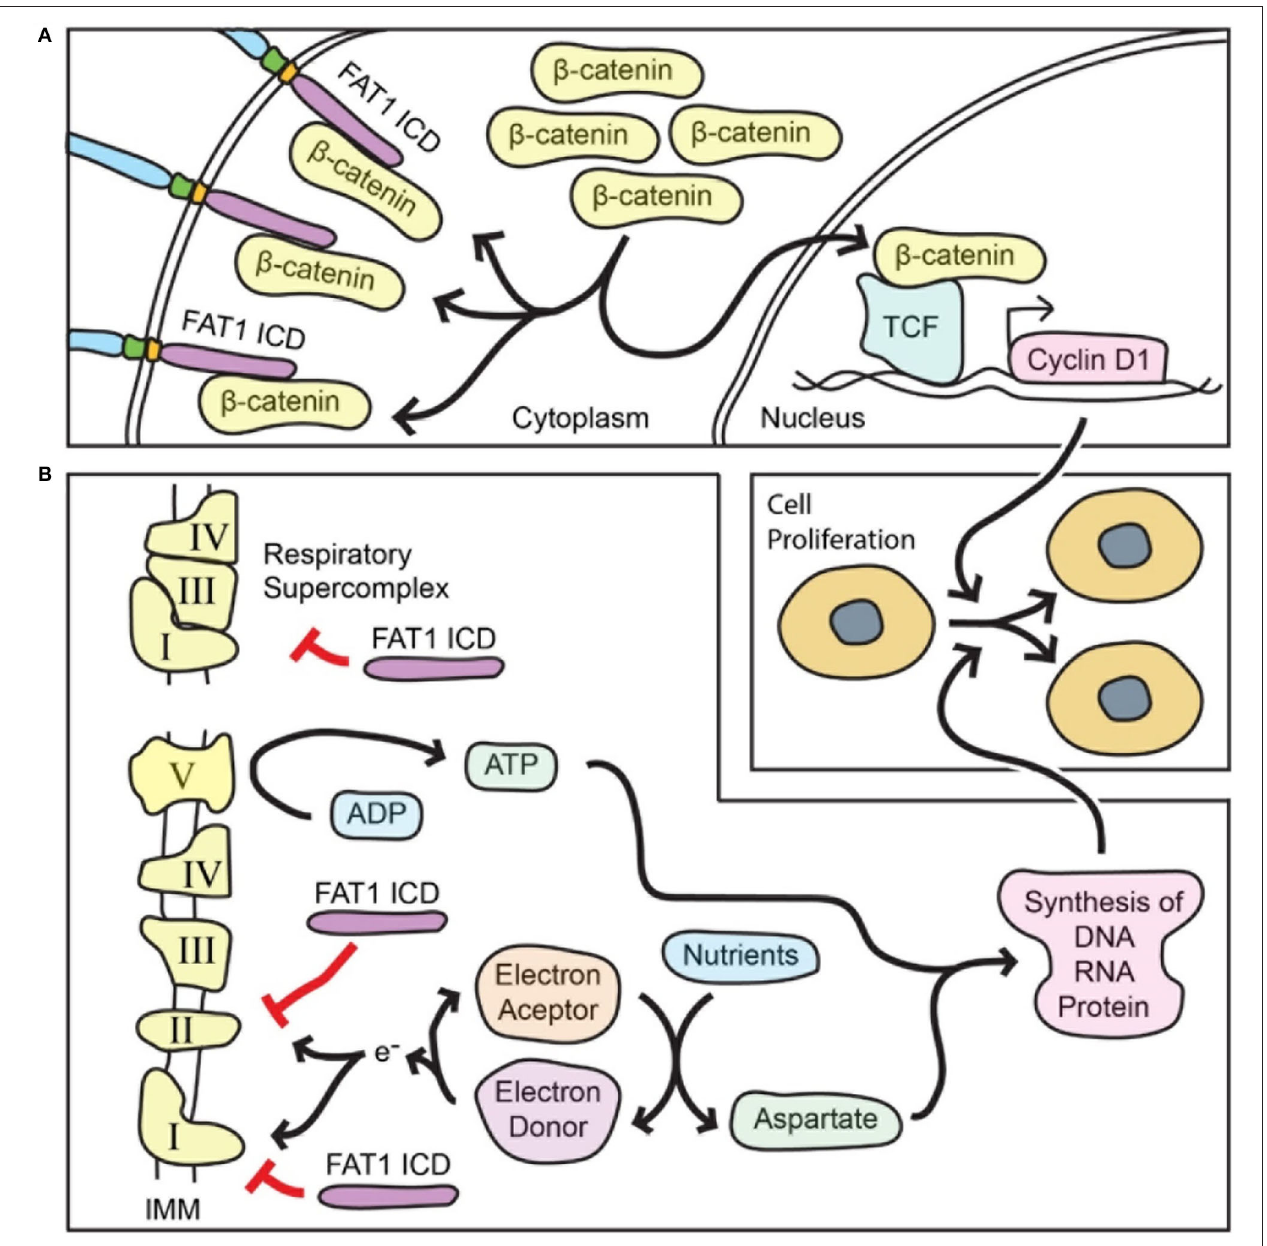
FIGURE 2 | FAT1 limits both β -catenin-mediated transcriptional activity and mitochondrial respiration in order to restrict vascular SMC proliferation. ( A) The FAT1 ICD interacts with β -catenin and decreases β -catenin accumulation in the nucleus. In general, nuclear β -catenin interacts with the TCF family of transcription factors to active transcription of target genes that promote cell proliferation such as the gene for cyclin D1, a key promoter of cell cycle progression. Thus, FAT1 suppresses the pro-proliferative function of β -catenin. ( B) The FAT1 ICD within mitochondria decreases the activity of respiratory complexes I and II, and the formation of respiratory supercomplexes; both of these effects reduce mitochondrial respiration. The respiratory function is essential for replenishing electron acceptors that in turn are necessary for aspartate biosynthesis from nutrients. Respiration also results in ATP synthesis. Both ATP and aspartate are essential for synthesis of macromolecules that are required for cell division. Thus, FAT1 suppresses the pro-proliferative function of mitochondrial respiration. IMM, inner mitochondrial